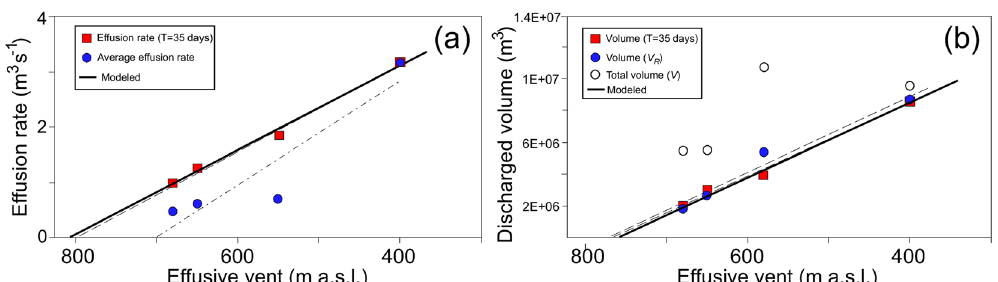
Figure 5. ( a ) Correlation between the elevations of the effusive vents and effusion rates (averaged over the whole duration and over the same 35 days’ time) during the studied effusive eruptions. ( b ) The discharge volume V R versus the elevation of the effusive vent is calculated, considering Q D = 0.3 m 3 s − 1 . Note that the intercepts of the trend lines and the lower axis coincide with the elevations (~750–780 m a.s.l.) of the active craters. Open circles refer to the total erupted volumes, V , assuming Q D = 0 m 3 s − 1 in equation (5). The modeled trends are also reported for comparison as the solid bold